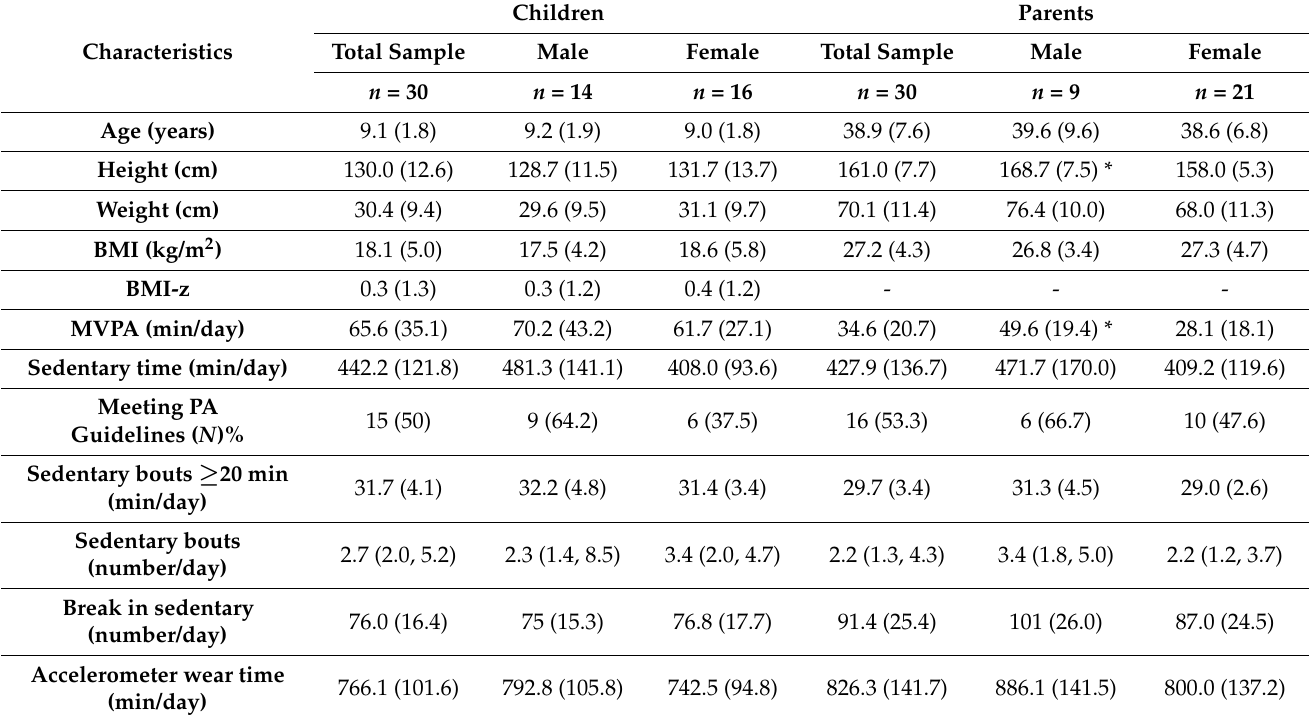
Table 2. Descriptive statistics for the study variables across groups that are stratified by gender.